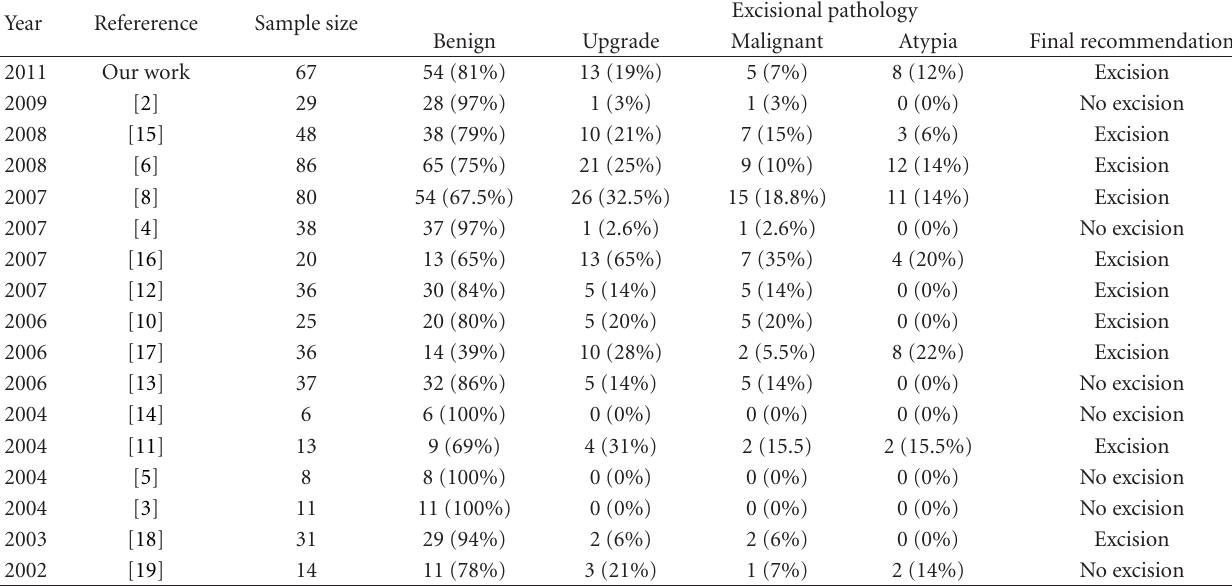
Table 2: Summary of literature: Benign papillary lesions diagnosed with core needle biopsy and followed up with surgical excision.